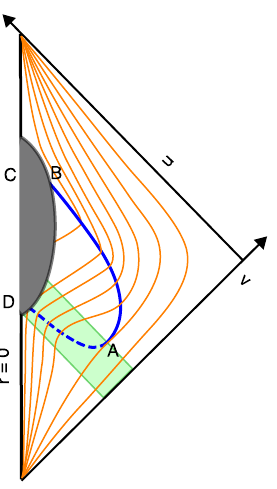
Figure 2 . The Penrose diagram with a trapping horizon. The part of the trapping horizon in vacuum is shown as a solid curve (in blue), and the part in matter as a dashed curve (in blue), with the diagonal stripe (in green) representing the collapsing matter. The gray area around the origin represents the high-curvature region behind which the points B , C and D in (cid:12)gure 1 are hidden. The constant- r curves (in orange) are tangent to constant- u lines on the trapping